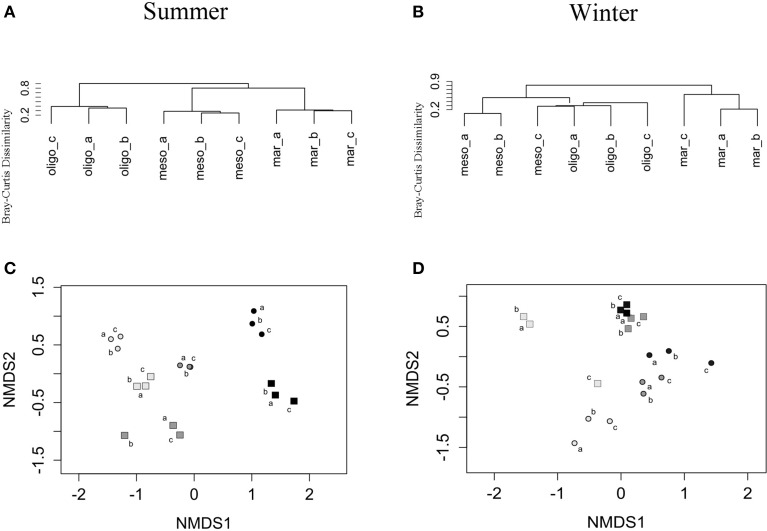
Unweighted-pair group method with arithmetic mean (UPGMA) dendrograms based on Bray–Curtis dissimilarities of total bacteria in summer (A) and winter samples (B) of the three stations (marine, mesohaline, oligohaline). And non-metric multidimensional scaling (NMDS) for particle-associated (PA) and free-living (FL) bacteria in summer (C) and winter samples (D) of the three stations, with light gray: stations considered as “marine” (mar), dark gray: stations considered as “mesohaline” (meso) and black: stations considered as “oligohaline” (oligo). So, summer; Wi, winter; squares, PA; and dots, FL.